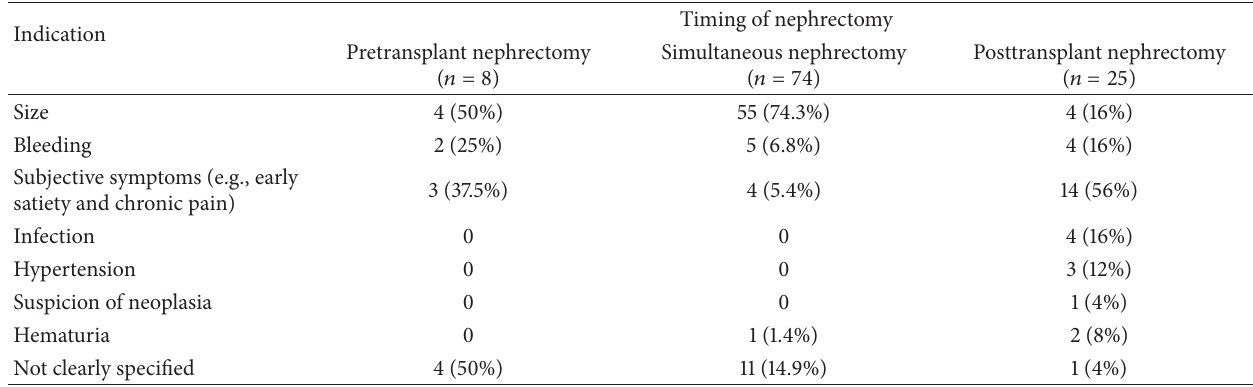
Table 1: Indications and timing of